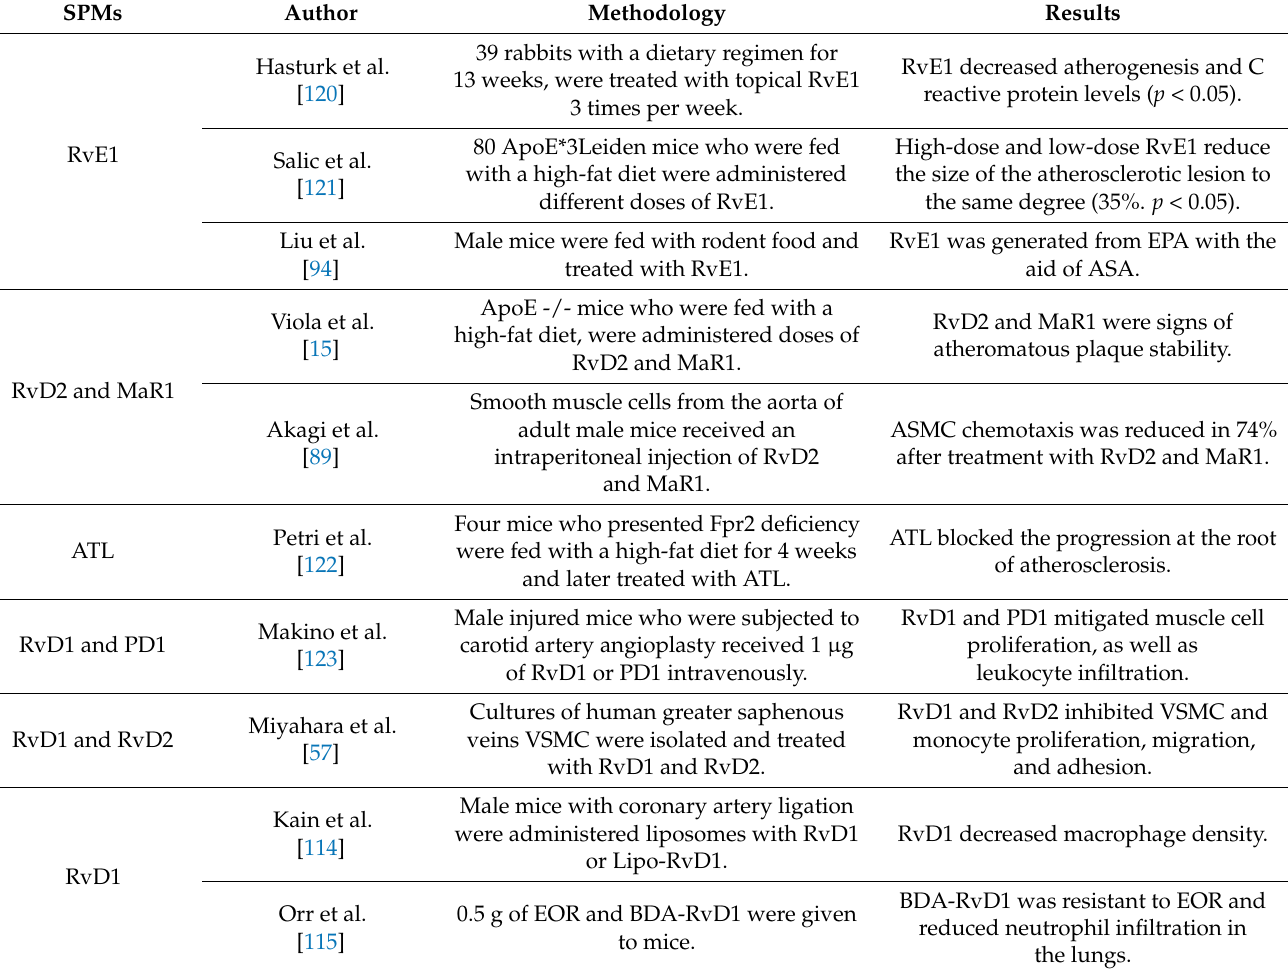
Table 3. Specialized proresolving lipid mediators as a therapeutic target in